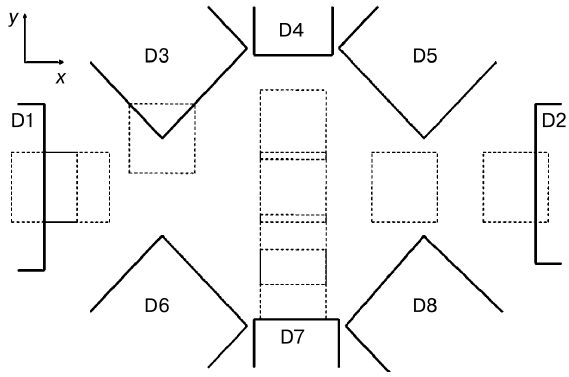
Figure 1. Schematic of test object showing positions of IDTs D1–D8. Dashes show measurement areas.